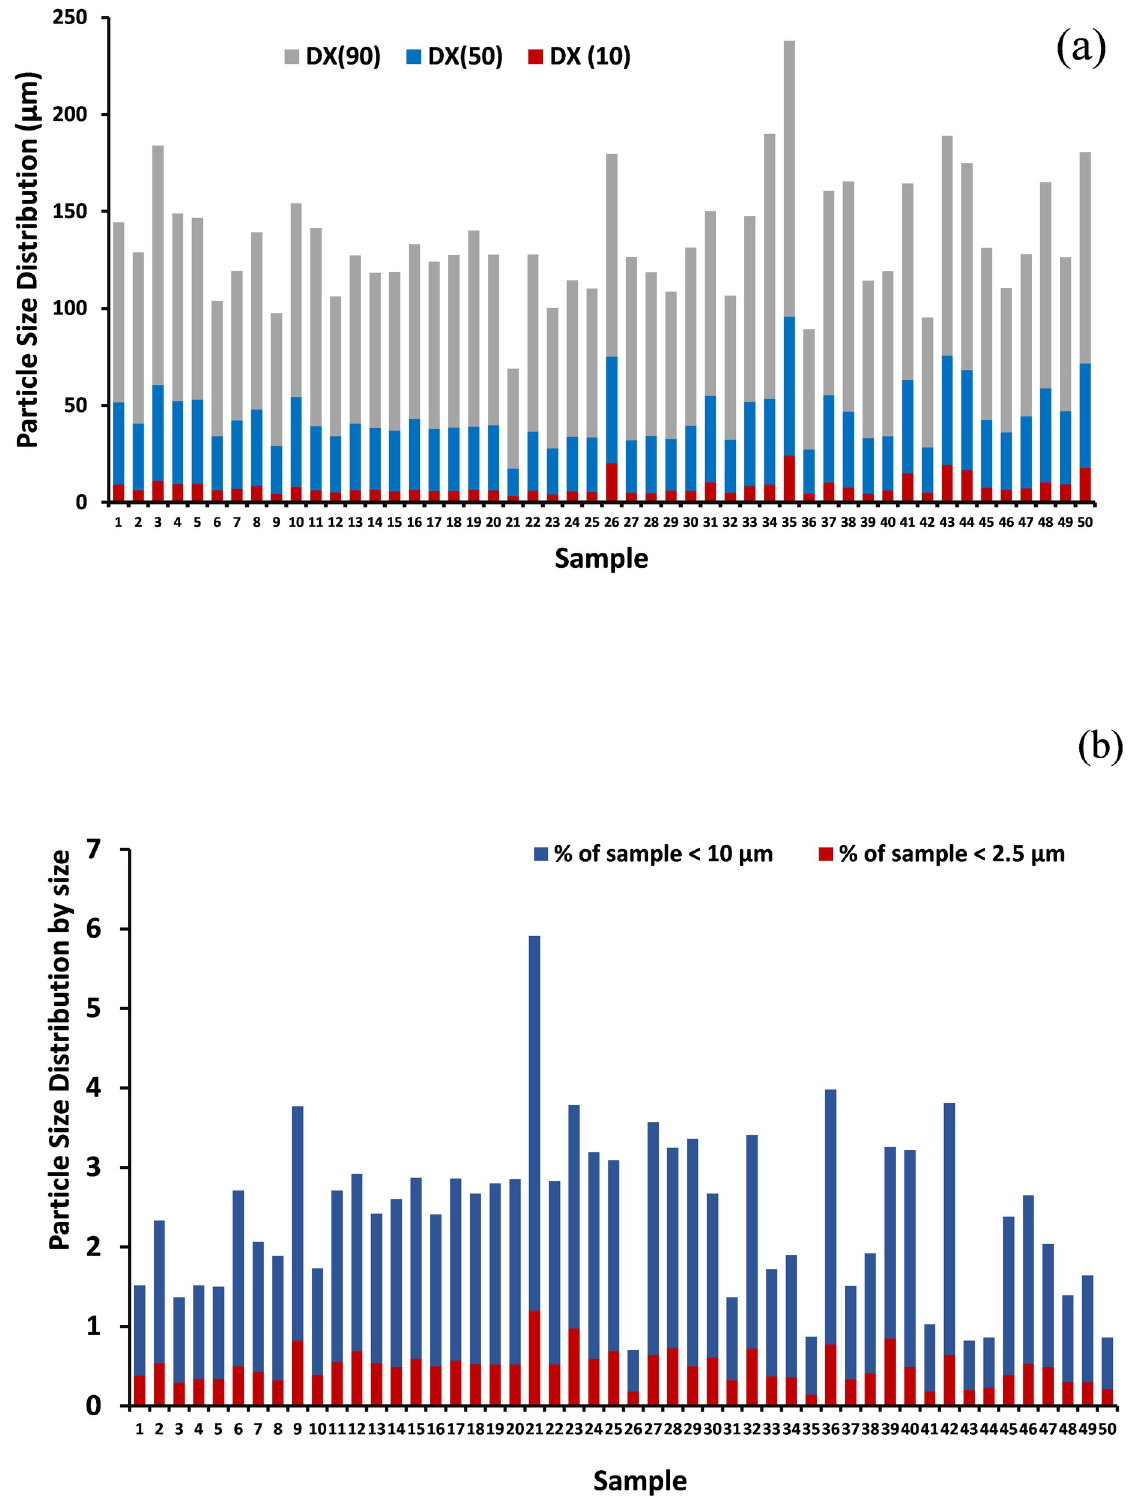
Fig 3. (a) Particle size distribution by volume (b) mass distribution of different size fractions of aerosol PM in the study area.